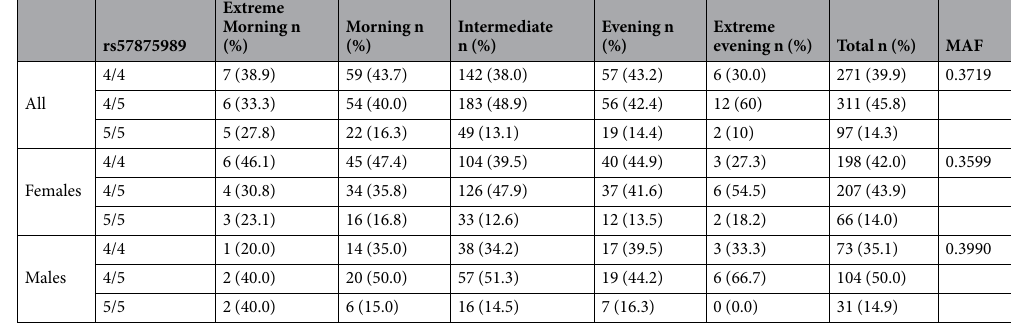
Table 1. PER3 genotypes at rs57875989 and minor allele frequencies, by diurnal preference. MAF: Minor Allele Frequency. No preferential associations between genotype/allele and diurnal preference were observed (Wald test: p = 0.737). This held true also when intermediate types were excluded and extreme morning/morning types and extreme evening/evening types were pooled (Cochran-Armitage test χ 2 = 0.069, p =